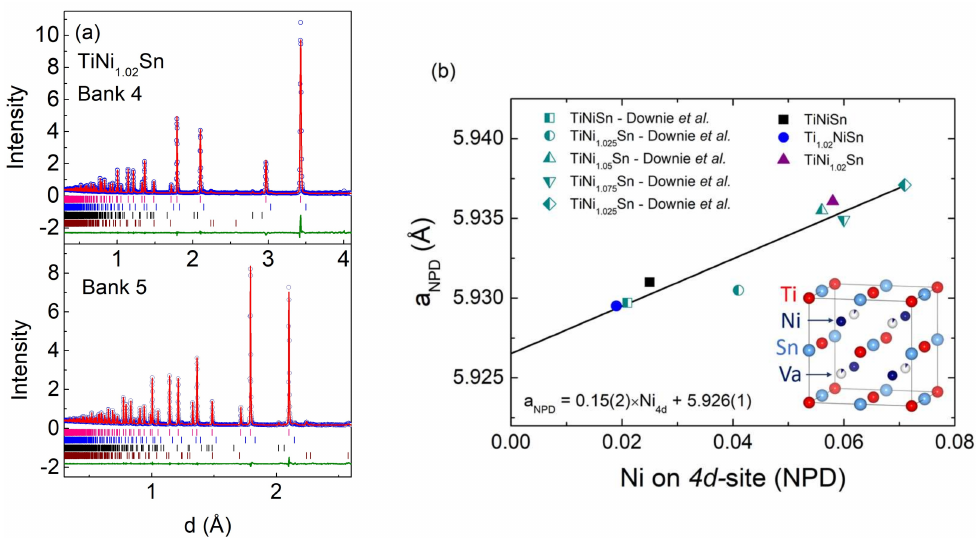
Figure 2. ( a ) Observed (blue circles), calculated (red line) and difference (green line) Rietveld neutron powder diffraction profiles for Ti 1.02 NiS. Bragg reflection markers correspond to (from top to bottom): half-Heusler; Sn and Ti. Banks 4 and 5 are the 90 ◦ and backscatter (2 θ ~147 ◦ ) detector banks on the Polaris instrument. ( b ) Interstitial Ni 4d site occupancy dependence of the half-Heusler lattice parameter using literature data [23,30] and the samples discussed here. The solid line is a linear fit. Table 3. Ni 4d-site occupancies, lattice thermal conductivity ( κ 323K -LT/ ρ ), experimental ( Γ )